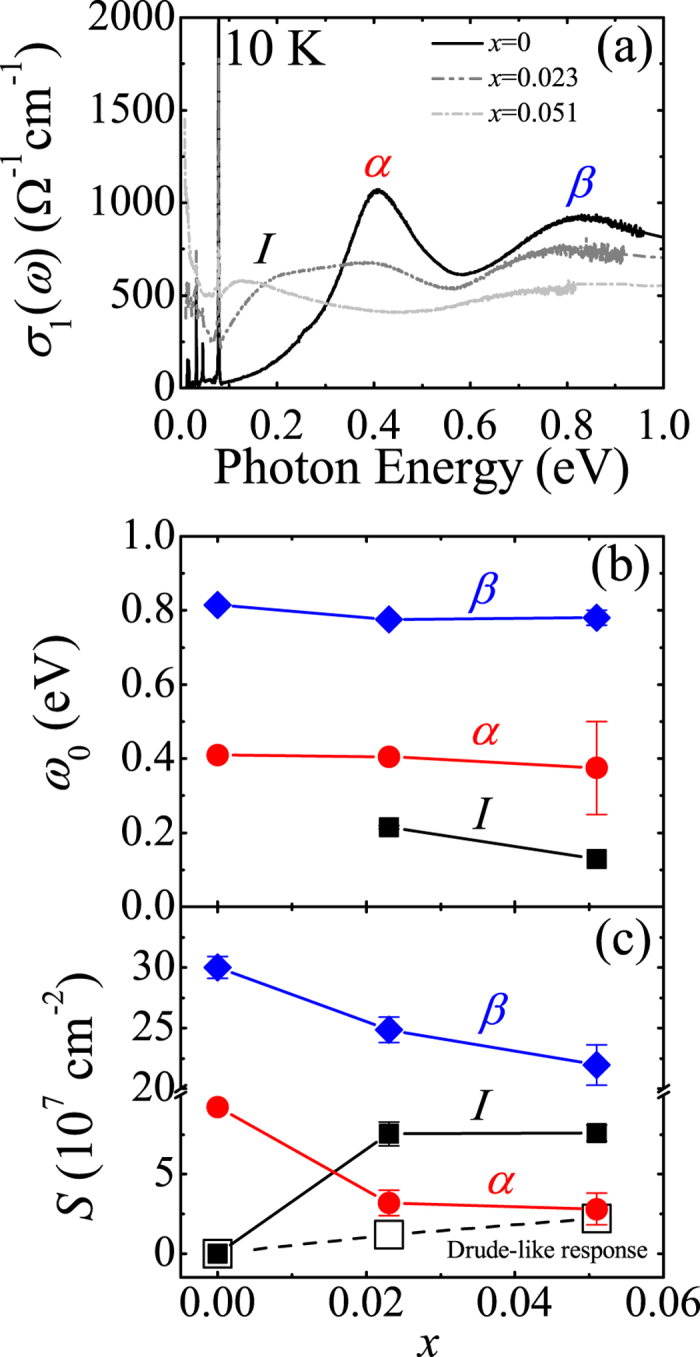
(a) σ1(ω) of (Sr1−xLax)3Ir2O7 at 10 K. (b) Resonant frequencies of the peaks I (solid squares), α (solid circles), and β (solid diamonds). (c) Strengths of the Drude-like response (open squares), the peaks I, α, and β.